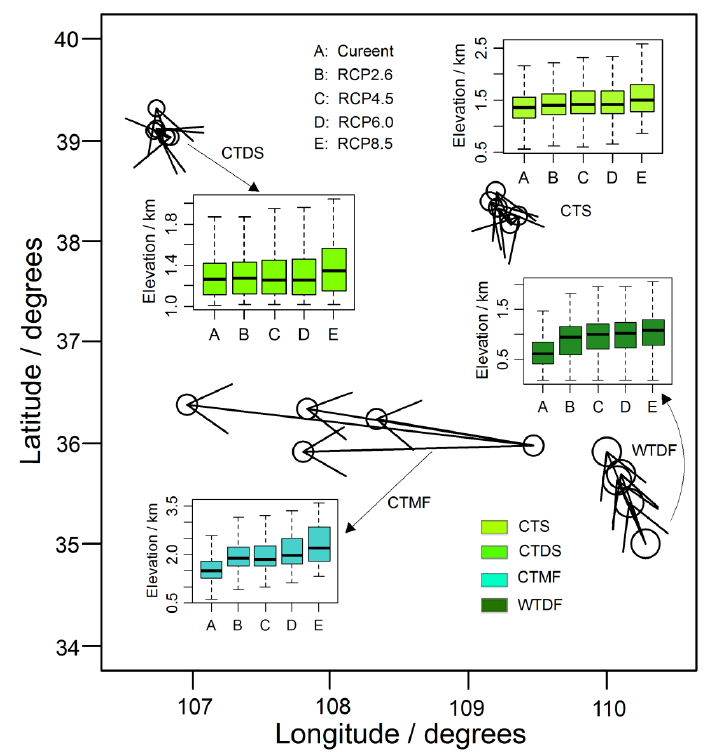
Figure 5. The zonal, meridional and vertical shift of four dominant vegetation zones on Loess Plateau. Cool temperate steppe (CTS), cool temperate desert scrub (CTDS), cool temperate moist forest (CTMF), and warm temperate dry forest